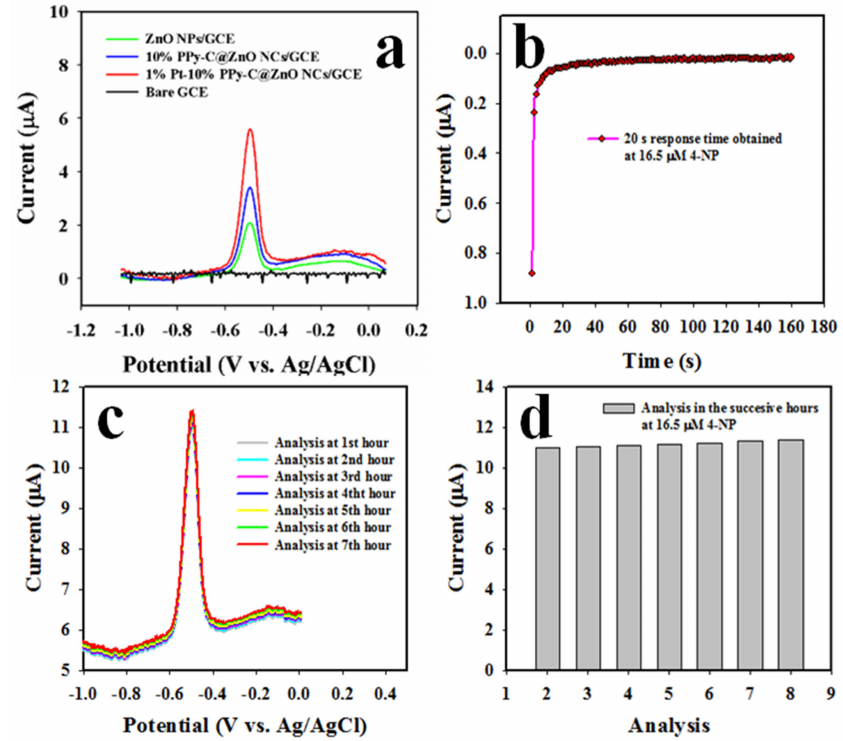
Figure 10. Analysis of sensor performance; ( a ) Control experiment in DPV analysis of 4 − NP, ( b ) Response time at current versus time, ( c ) Reproducibility of 4 − NP sensor, and ( d ) Reproducibility bar